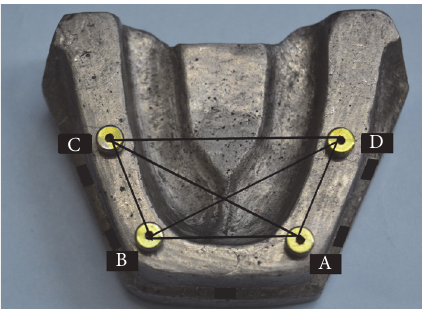
Figure 1: Reference model with implants and healing abutments in